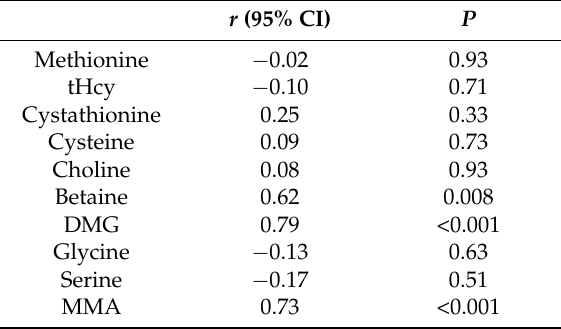
Table 1. Correlations between blood and urinary concentrations of metabolites. Male Wistar rats were treated with either a low-fat control diet or a high-fat diet with or without additional TTA treatment, n = 17. Pearson correlation coefficients were calculated between the plasma and urinary concentration of metabolites. r (95% CI) P Methionine ´ 0.02 ´ 0.10